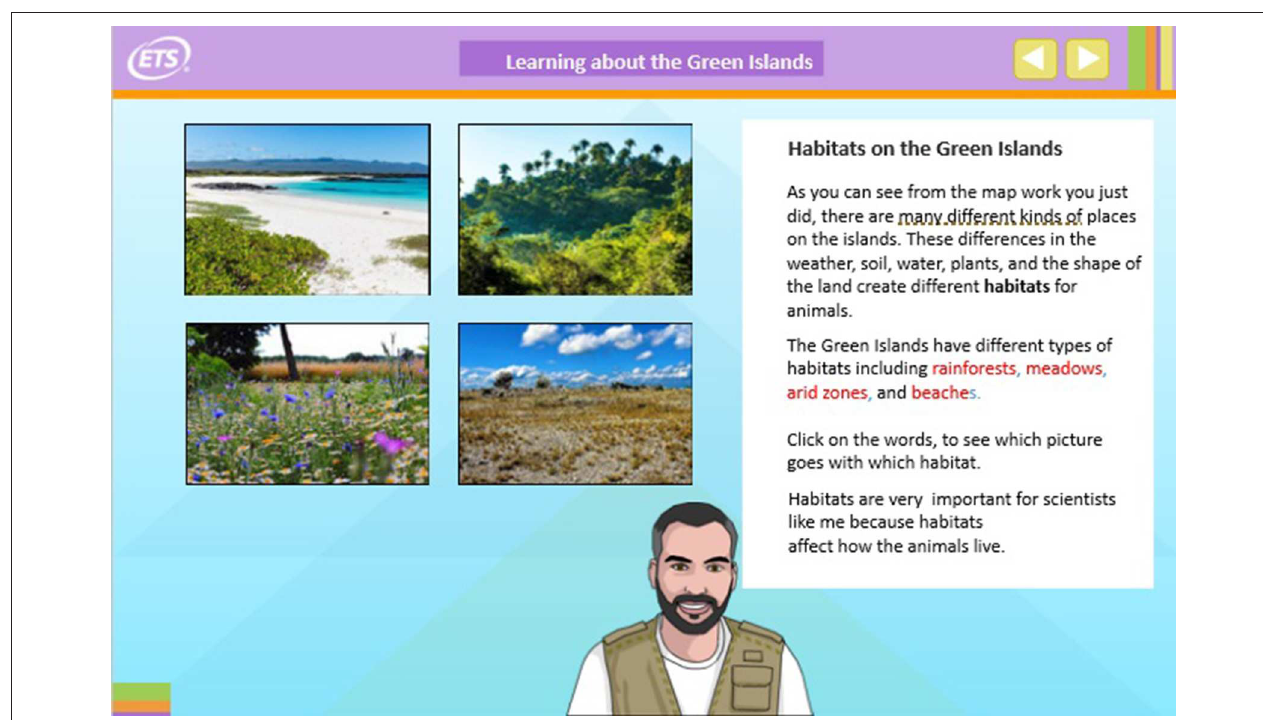
FIGURE 4 | Example of an interactive activity to learn the habitats on the Green